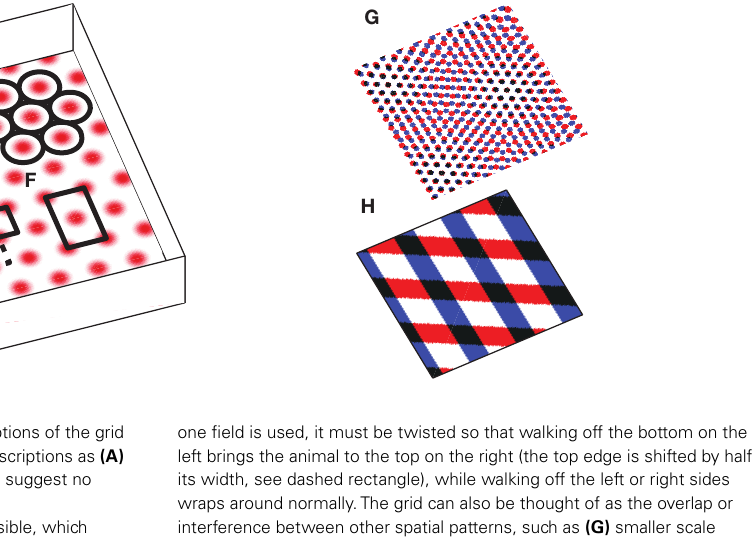
FIGURE 1 |The grid cell spatial pattern. Different descriptions of the grid suggest different underlying mechanisms.The simplest descriptions as (A) an equilateral triangular tessellation or (B) a hexagonal grid suggest no obvious mechanism. (C) The pattern can be thought of as inactivity-surrounded place fields packed as closely as possible, which leads to Kropff andTreves (2008). Alternatively, the regularity of the pattern suggests that perhaps only a small segment, e.g., (D) a rhombus (skewed rectangle) or a rectangle large enough for (E) only one or (F) two or more appropriately spaced fields, is represented and when the animal walks off the segment it re-enters from the other side. If a rectangle containing only